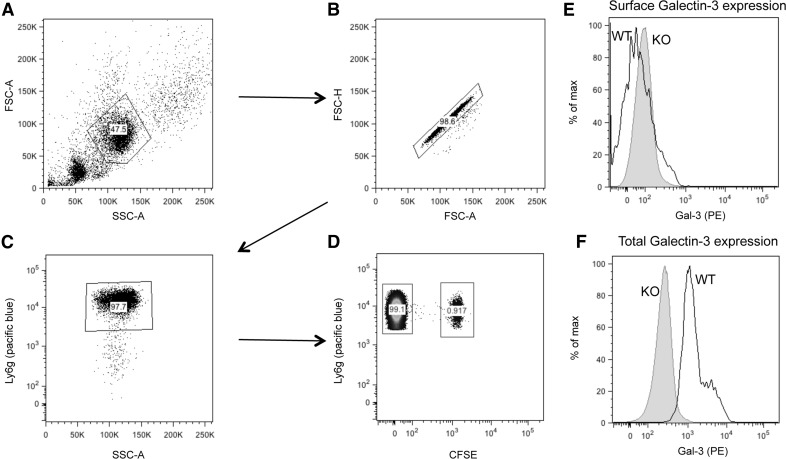
WT neutrophils exhibit increased Gal-3 expression upon transmigration to the peritoneal cavities of Gal-3–null mice.Bone marrow neutrophils were isolated from WT mice, labeled with CFSE, and administered i.v. to Gal-3–null mice, which subsequently underwent a zymosan (1 mg)–induced peritonitis. Peritoneal cavities were lavaged at 4 h and analyzed by flow cytometry. (A) Neutrophils were identifiable by their characteristic forward/side light scatter (FSC/SSC) profile. Following doublet exclusion (B), Ly6G+ neutrophils were identified (C). (D) WT Ly6G+ neutrophils were identified by their positive CFSE staining. Surface (E) and total (F) Gal-3 expression was measured on CFSE− (neutrophils from Gal-3–null mice) and CFSE+ cells (neutrophils from WT mice) by flow cytometry, and representative histograms are shown. Max, maximum; PE, peritoneal exudate.